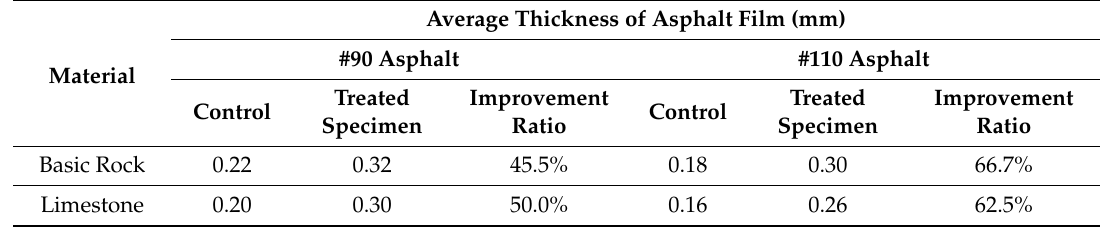
Table 4. The measured asphalt film thickness on aggregates and relative improvement.